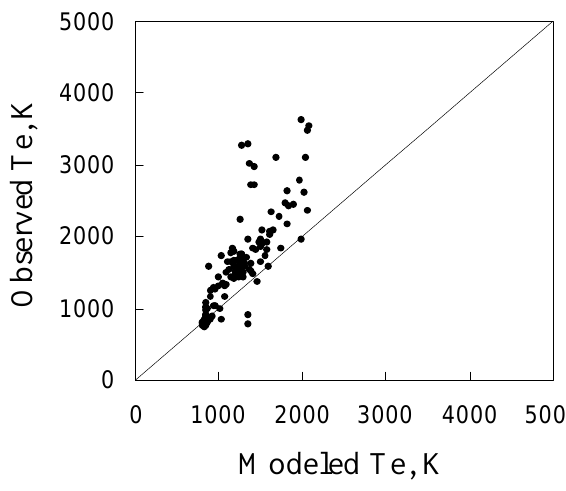
Fig. 7. Scatter plot of observed electron temperature at ∼ 500km against the temperature predicted by the IRI model for Fig.7. Scatter plot of observed electron temperature at ~500 km against the temperature predicted by the IRI model for equinoxes.